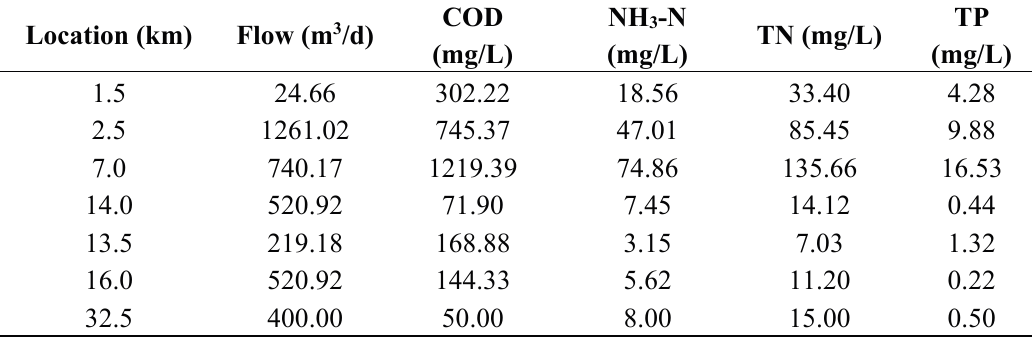
Table 4. Flow and concentration of main point